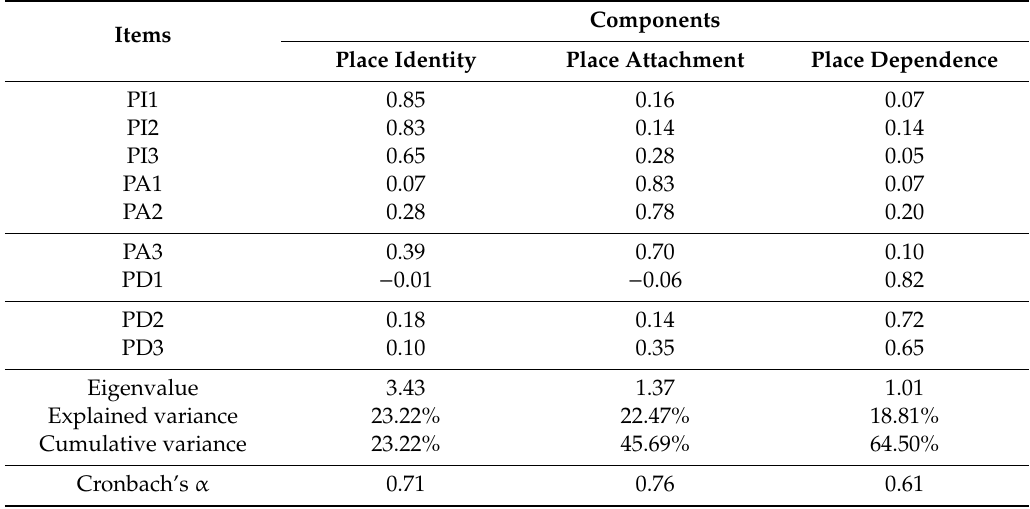
Table 2. Component matrixes for respective components of sense of place after rotation.